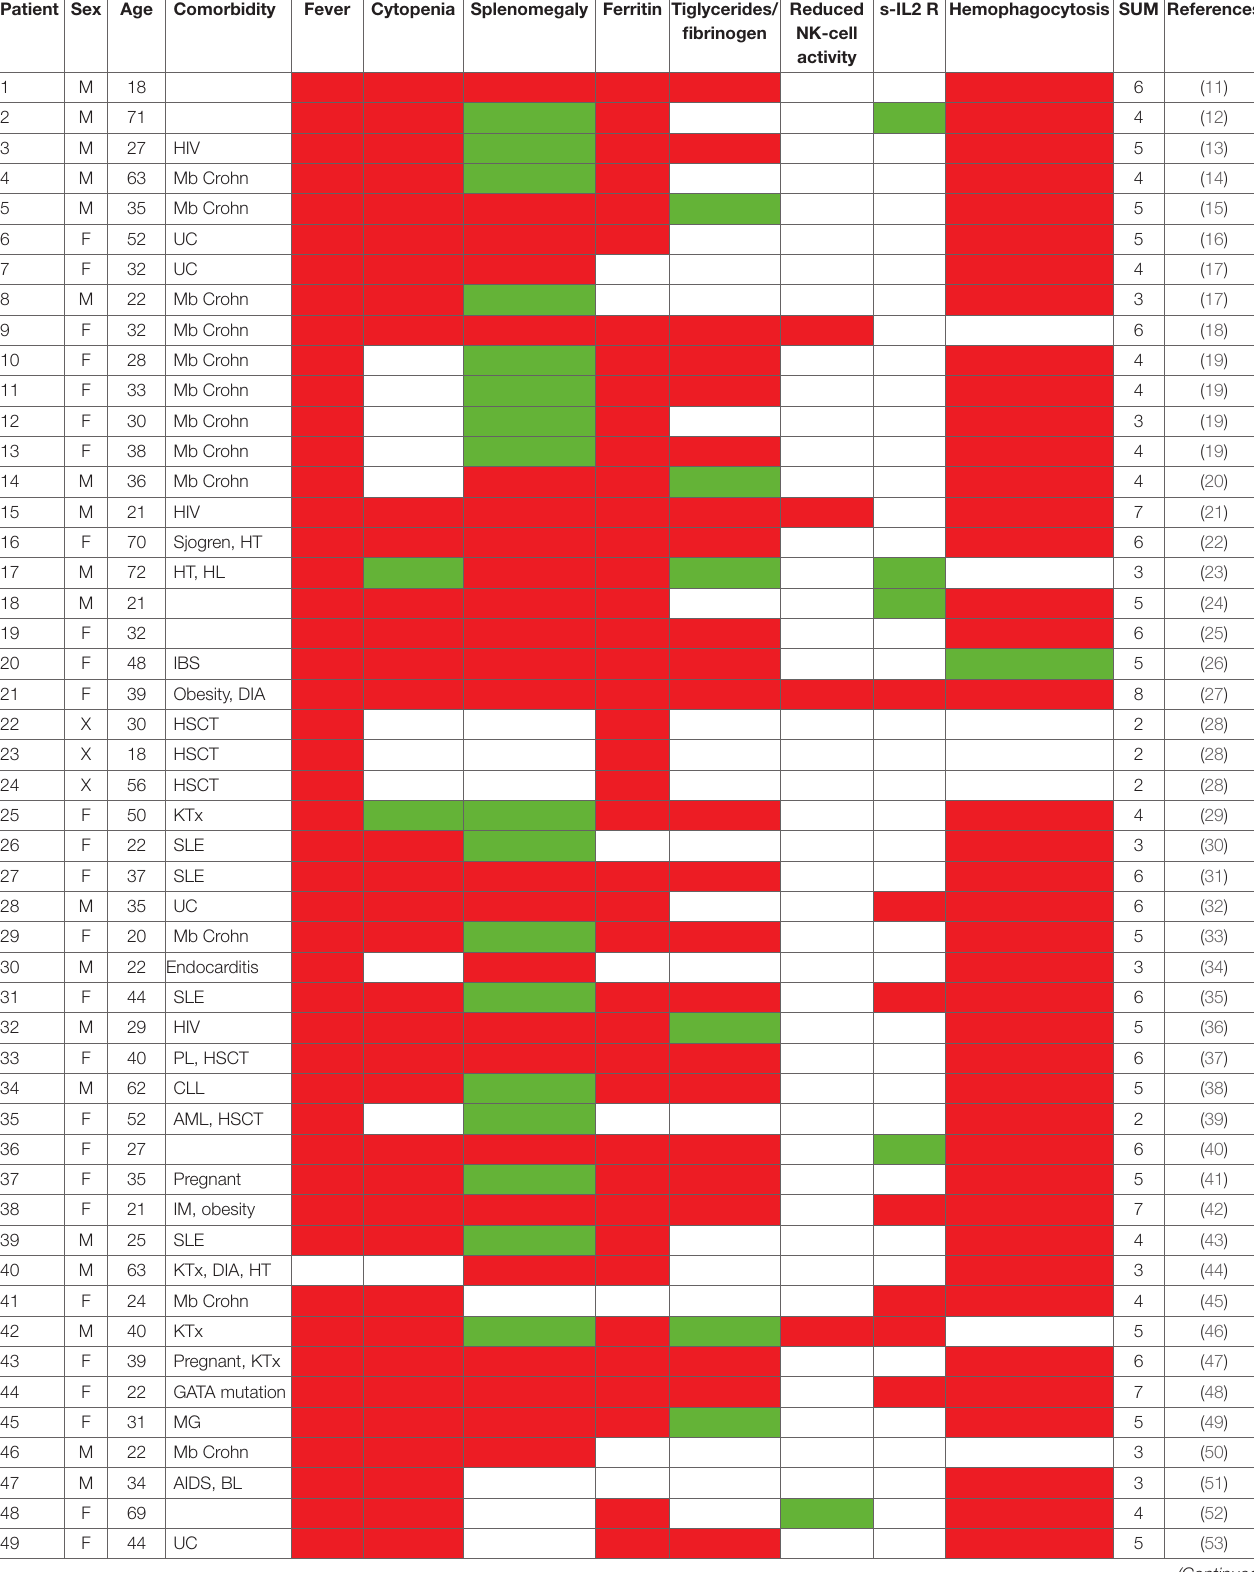
TABLE 5 | Presence or absence of HLH-2004 clinical criteria in each patient reviewed. Patient Sex Age